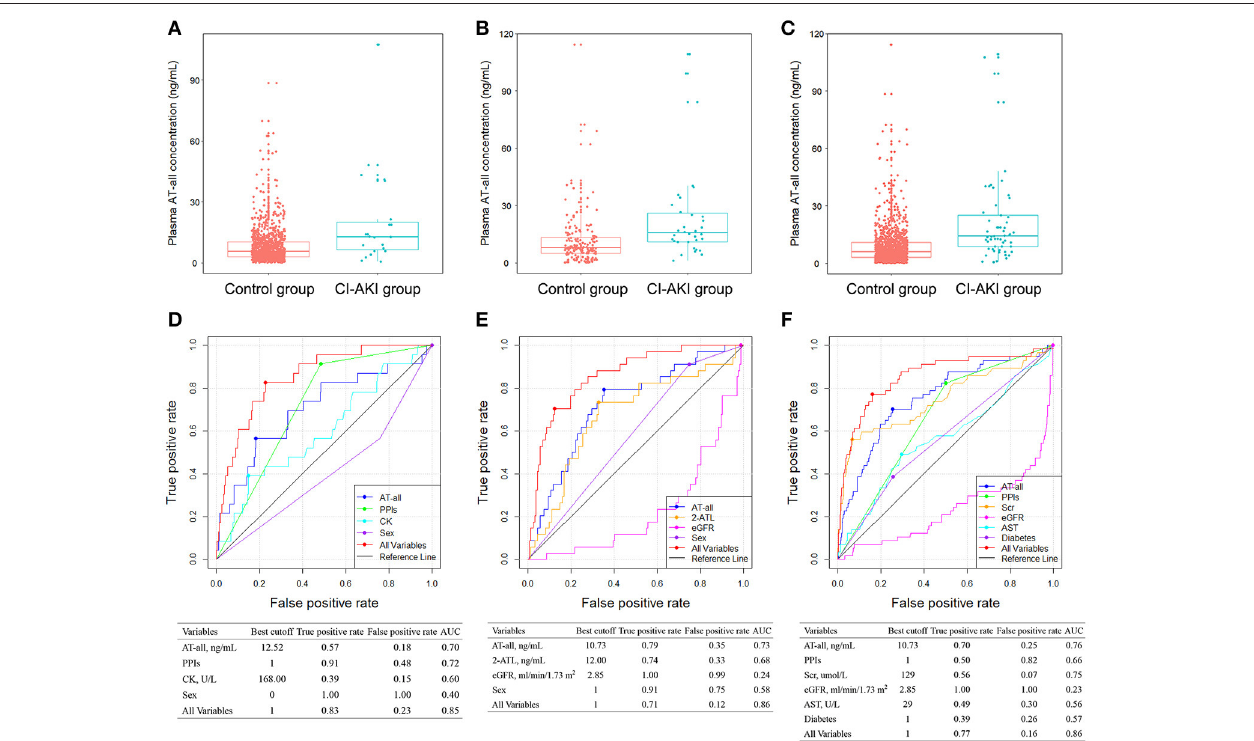
FIGURE 2 | Comparison of plasma AT-all concentration between control group and CI-AKI group in patients without CKD (A) , in patients with CKD (B) , and in all patients (C) in stage I. ROC analyses of variables for predicting CI-AKI in patients without CKD (D ), in patients with CKD (E) , and in all patients (F) in stage I. 2-ATL, 2-hydroxy atorvastatin lactone; AST, aspartate aminotransferase; CK, creatine kinase; eGFR, estimated glomerular filtration rate; PPIs, proton pump inhibitors; ROC, receiver operating characteristic; Scr, serum creatinine; other abbreviations as in Figure 1